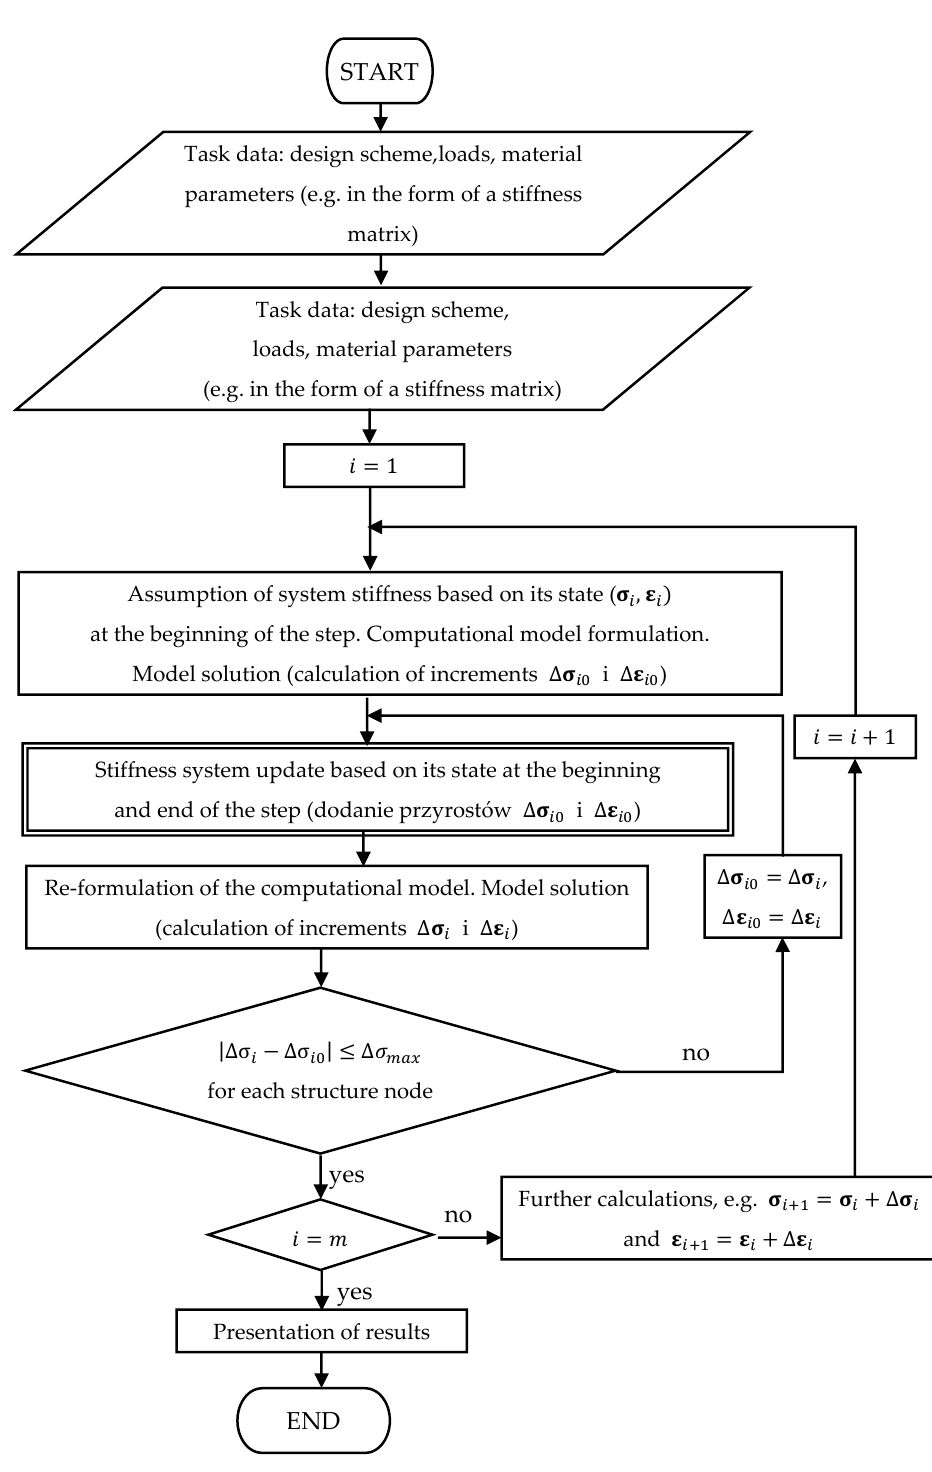
Figure 5. A flowchart of the calculation algorithm.